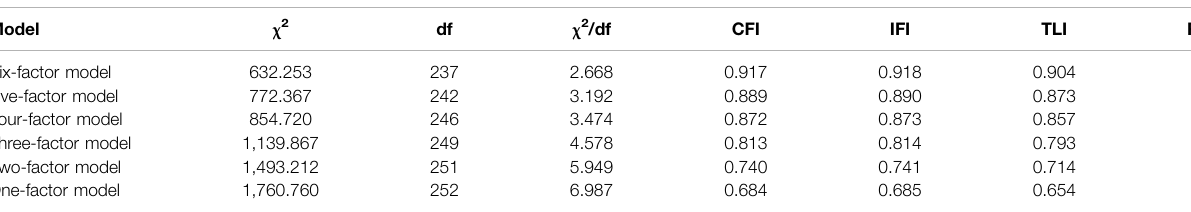
TABLE 2 | Con fi rmatory factor analysis.